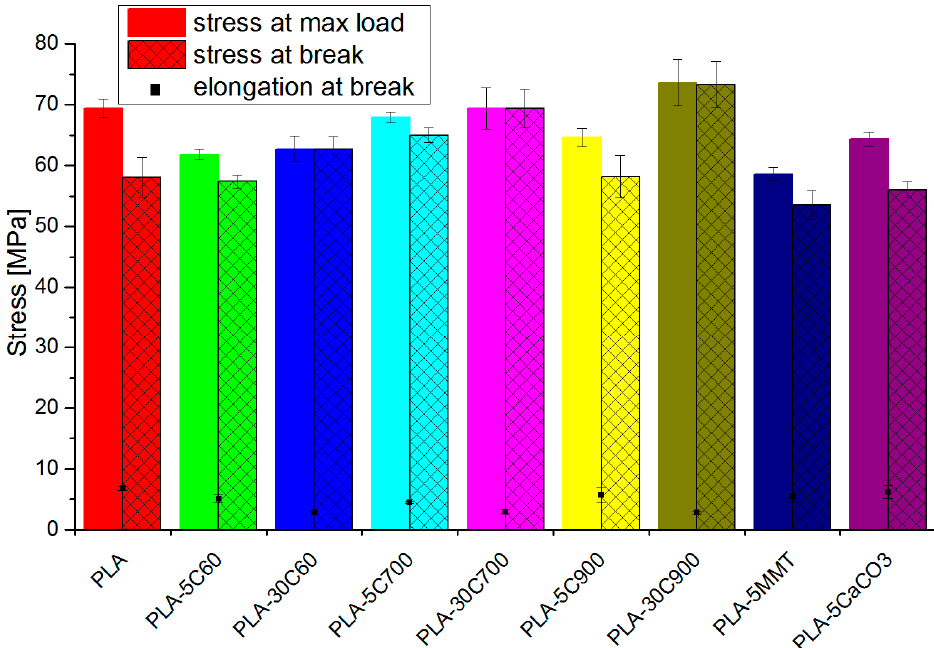
Figure 7. Tensile strength and stress (bars) and elongation at break (rectangular points). Similarly, at bending measurements, Young’s modulus increased with the fibre length. The increment rate for 5 wt.% fibre composites is observable, but not that contrary to composites with 30 wt.% loadings (Figure 8).